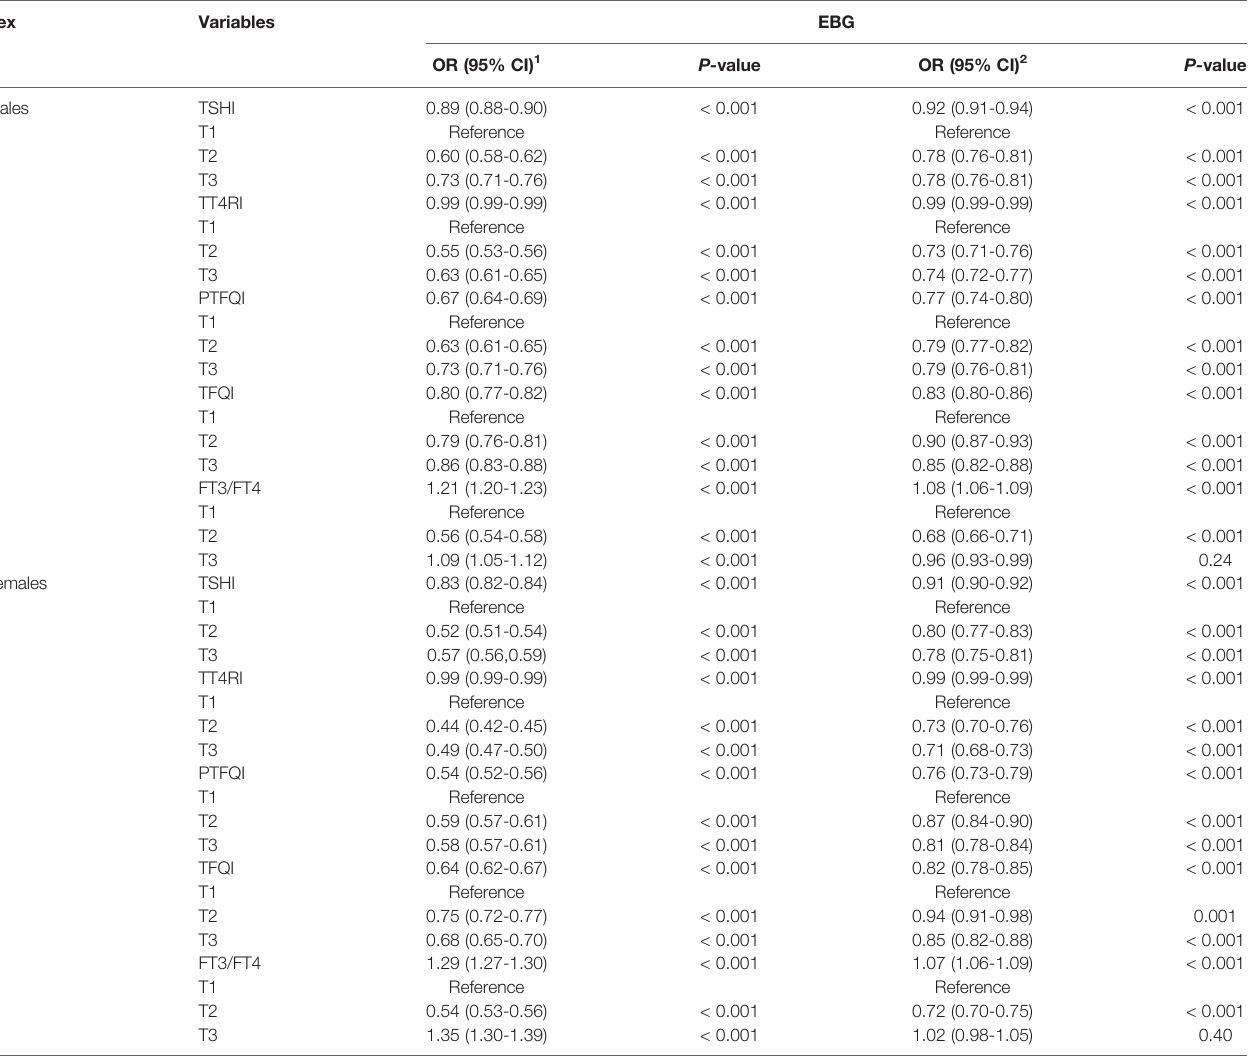
TABLE 3 | Relationship between thyroid hormone sensitivity and EBG in different sexes.